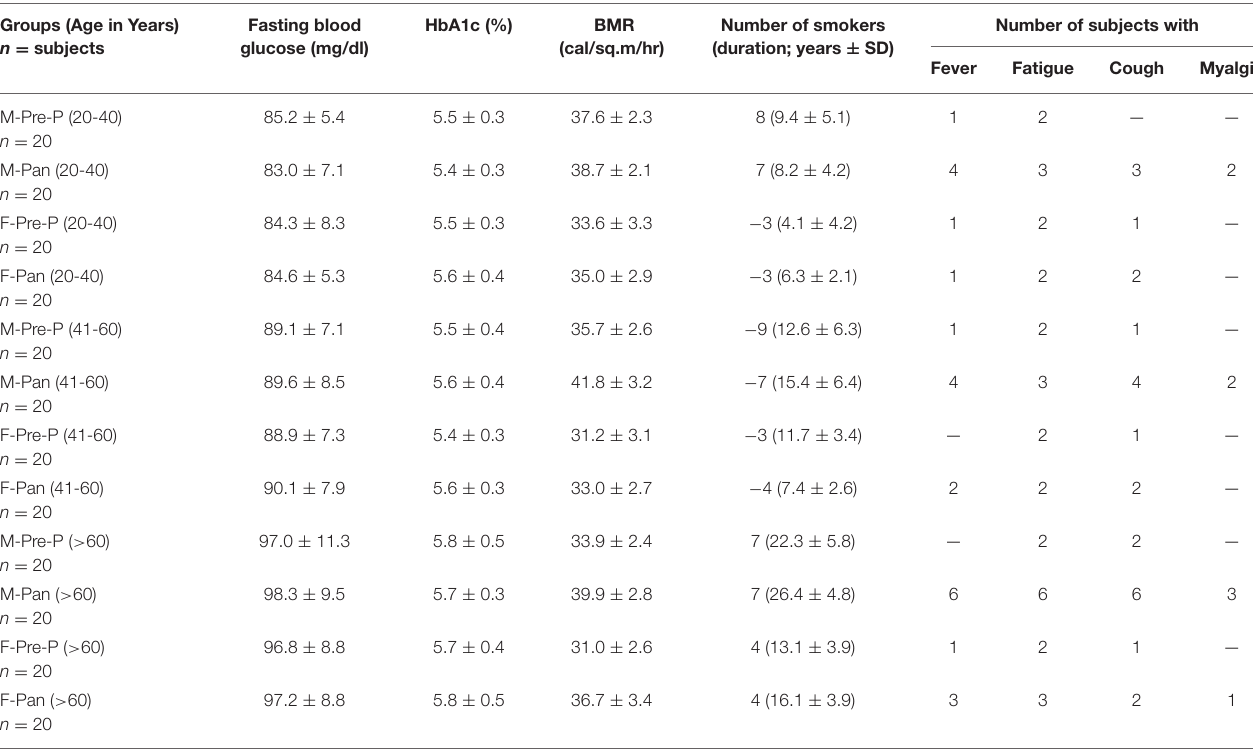
TABLE 1 | Group characteristics of study population. Groups (Age in Years) n = subjects